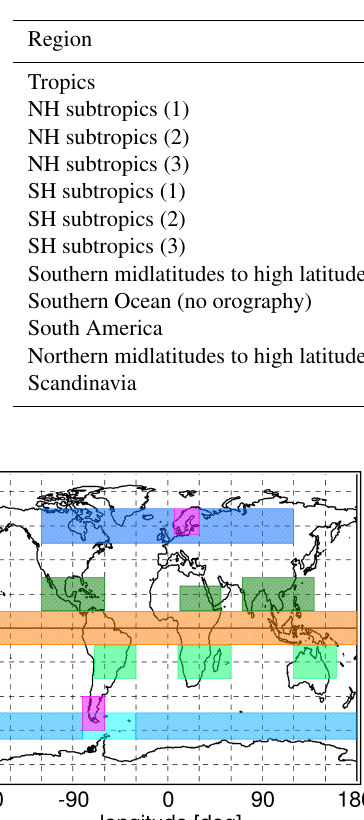
Table 1. Latitude–longitude ranges of the different regions illustrated in Fig. 5.